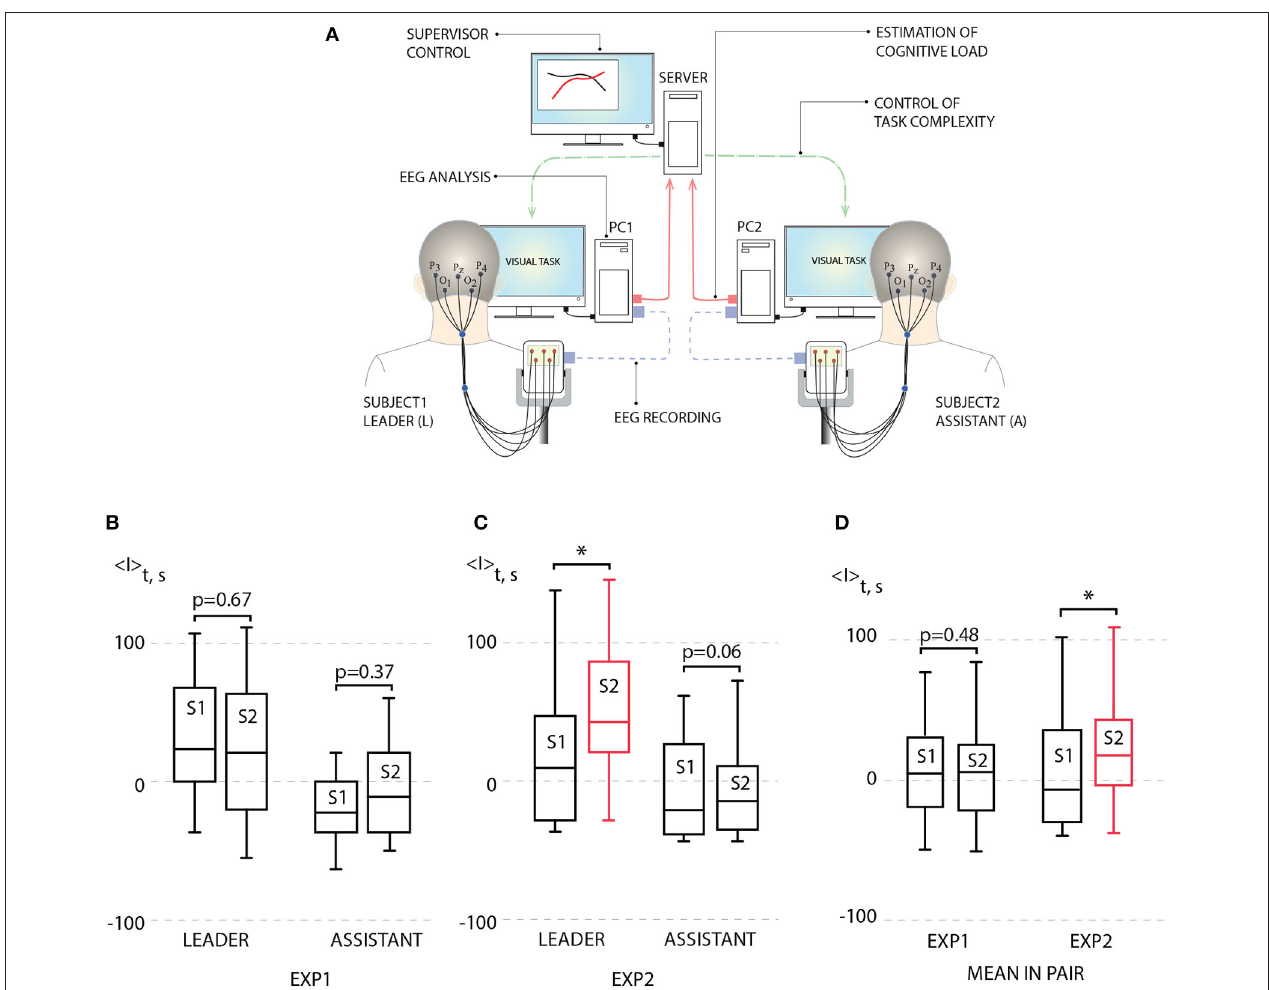
FIGURE 3 | (A) Schematic illustration of human-to-human interaction through BBI. (B) Left: average leader’s brain response h I i during first experiment (EXP1): session 1 (S1) [no link between subjects, p = 0.938 by Shapiro-Wilk normality test (SWNT)] and session 2 (S2) (no delay in coupling between subjects, p = 0.965 by SWNT) (not significant, n = 10, p = 0.67 by paired sample t -test); right: average assistant’s brain response h I i during EXP1: S1 (no link between subjects, p = 0.402 by SWNT) and S2 (no delay in coupling between subjects, p = 0.485 by SWNT) (not significant, n = 10, p = 0.37 by paired sample t -test). (C) Left: average leader’s brain response h I i during second experiment (EXP2): S1 (no link between subjects, p = 0.131 by SWNT) and S2 (delayed coupling between subjects, p = 0.889 by SWNT) (significant change, n = 10, * p < 0.05 by paired sample t-test); right: average assistant’s brain response h I i during EXP2: S1 (no link between subjects, p = 0.099 by SWNT) and S2 (delayed coupling between subjects, p = 0.169 by SWNT) (not significant, n = 10, p = 0.06 by paired sample t-test). (D) Left: mean brain response h I i for pairs during EXP1: S1 (no link between subjects, p = 0.979 by SWNT) and S2 (no delay in coupling between subjects, p = 0.847 by SWNT) (not significant, n = 10, p = 0.48 by paired sample t-test); right: mean brain response h I i for pairs during EXP1: S1 (no link between subjects, p = 0.108 by SWNT) and S2 (no delay in coupling between subjects, p = 0.622 by SWNT) (significant change, n = 10, * p < 0.05 by paired sample t -test). Medians (bars), 25–75 percentiles (box) and outlines (whiskers) are